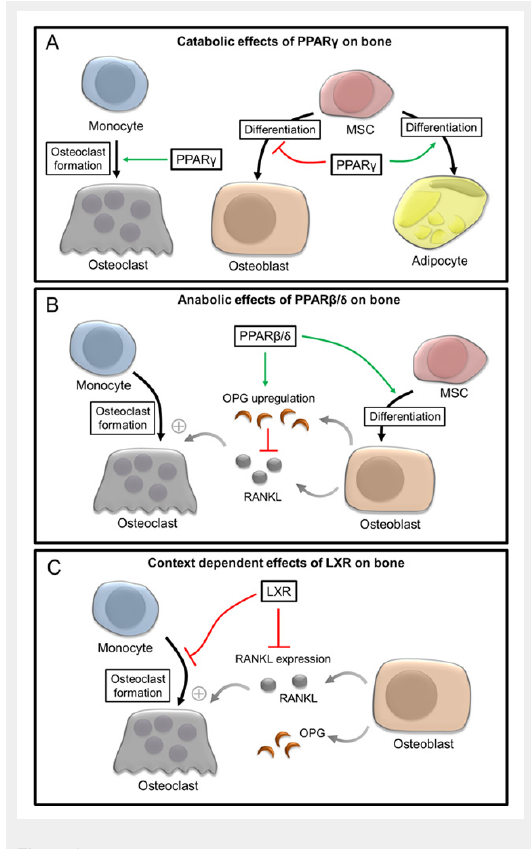
Role of PPARγ, PPARβ/δ and LXRs during the control of osteoblast and osteoclast differentiation. (A) Catabolic effects of PPARγ on bone homeostasis are attributed to the PPARγ-mediated promotion of osteoclast differentiation and its inhibitory role during the differentiation of mesenchymal stem cells (MSC) into osteoblasts. (B) PPARβ/δ exert its anabolic effects on bone homeostasis via promotion of the osteoblast differentiation and regulation of the RANKL/OPG ratio thereby indirectly influencing osteoclastogenesis. (C) During states of increased osteoclastogenesis and high bone turnover such as inflammation and osteoporosis, activation of LXRs is able to both directly and indirectly interfere with osteoclast differentiation via blockade of osteoclastogenesis and influencing the RANKL/OPG